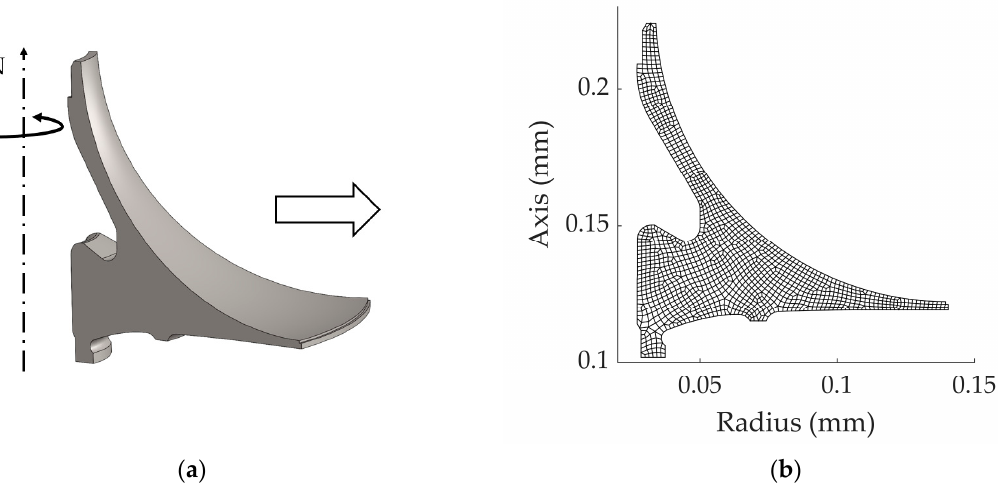
Figure 4. Geometric and mesh characteristics of centrifugal compressor impeller: ( a ) 1/10 sector of compressor disk; ( b ) radial–axial cross section size and mesh division results. Table 1. Boundary conditions of finite element analysis.